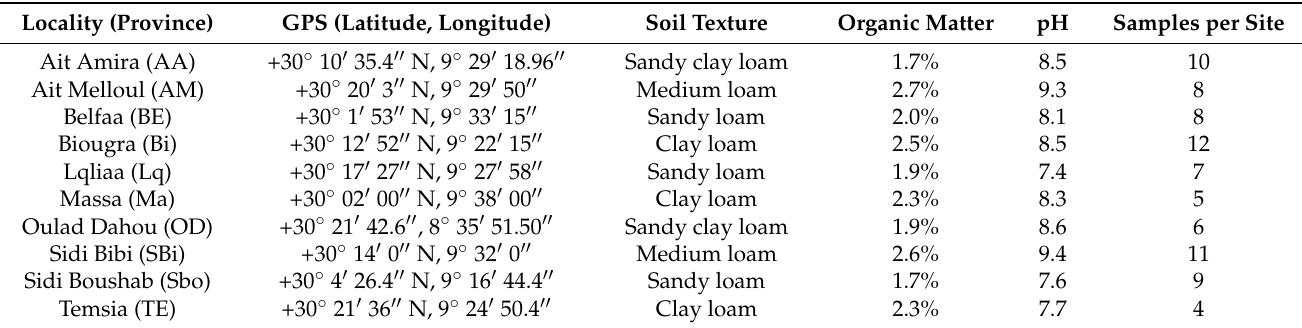
Table 1. Locations and characteristics of sampling sites of the surveyed cereal-growing regions in Southern